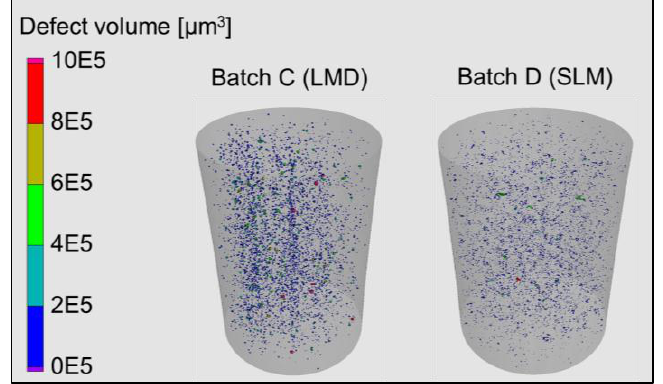
Figure 10. Defect distribution from µ-CT to batches: C (Scalmalloy ® LMD) and D (Scalmalloy ® SLM).